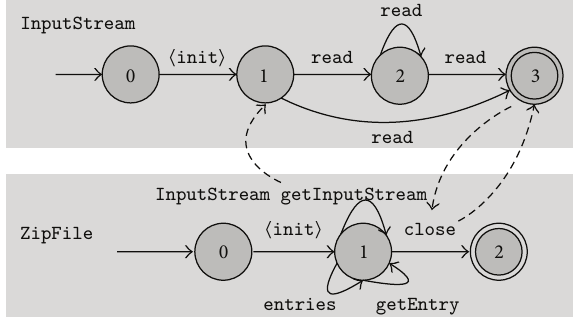
Figure 3: Mined typestates of ZipFile and InputStream .